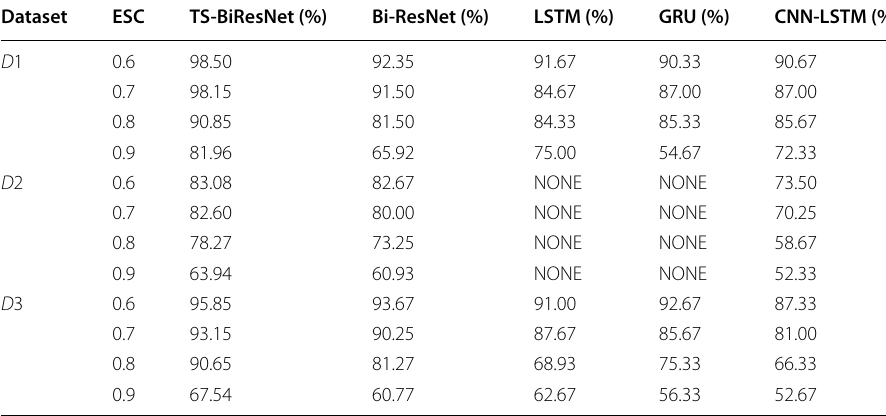
Table 3 Comparison of prediction accuracy for three datasets